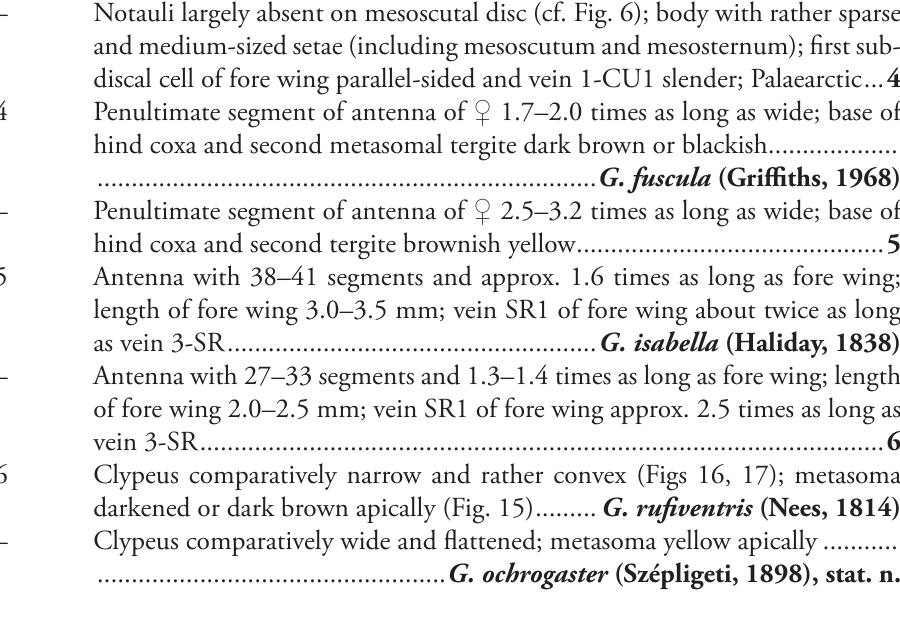
Vein CU1b of fore wing absent, resulting in partly open first subdiscal cell (Figs 1, 4); antenna approx. 0.9 times as long as body or fore wing; vein r is- sued near basal 0.4 of pterostigma (Fig. 4); marginal cell wide basally (Fig. 4); Notauli complete; body with many long setae (including mesoscutum and mesosternum); first subdiscal cell of fore wing widened distally and vein 1-CU1 widened; [third antennal segment 1.4–1.5 times as long as fourth segment; vein m-cu of fore wing antefurcal (not postfurcal as mentioned in original (Chinese) description)]; Oriental (East China, Fujian) ..................... – Notauli largely absent on mesoscutal disc (cf. Fig. 6); body with rather sparse and medium-sized setae (including mesoscutum and mesosternum); first sub- discal cell of fore wing parallel-sided and vein 1-CU1 slender; Palaearctic ... 4 4 Penultimate segment of antenna of ♀ 1.7–2.0 times as long as wide; base of hind coxa and second metasomal tergite dark brown or blackish ................... – Penultimate segment of antenna of ♀ 2.5–3.2 times as long as wide; base of Antenna with 38–41 segments and approx. 1.6 times as long as fore wing; length of fore wing 3.0–3.5 mm; vein SR1 of fore wing about twice as long Antenna with 27–33 segments and 1.3–1.4 times as long as fore wing;